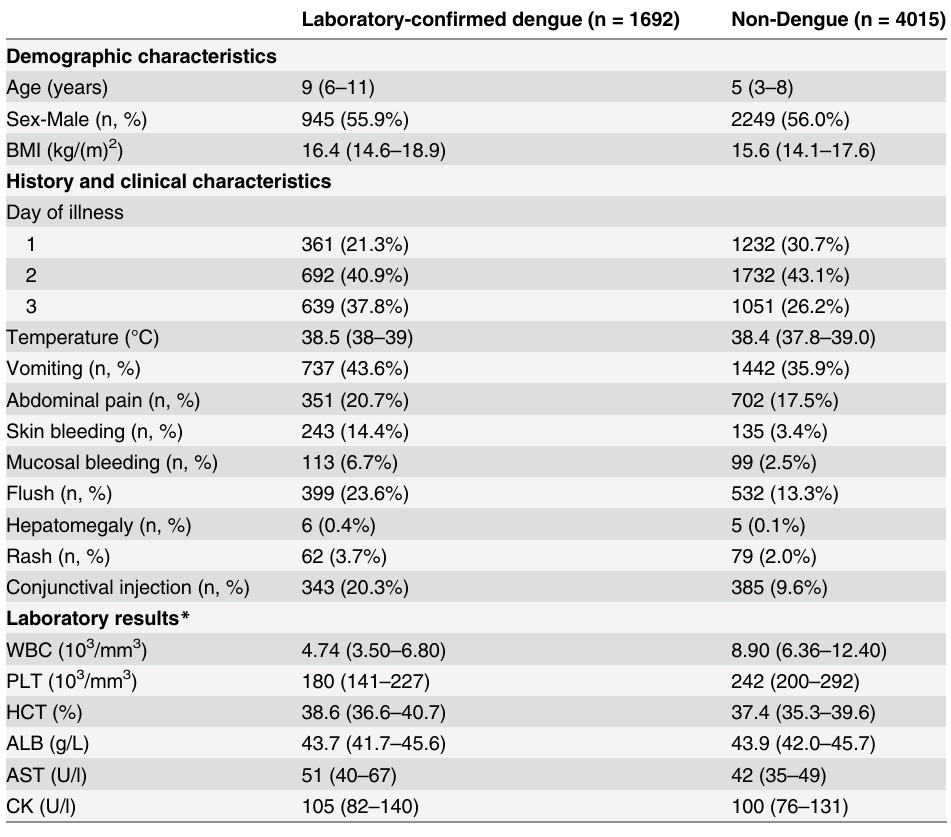
Table 1. Baseline characteristics of study